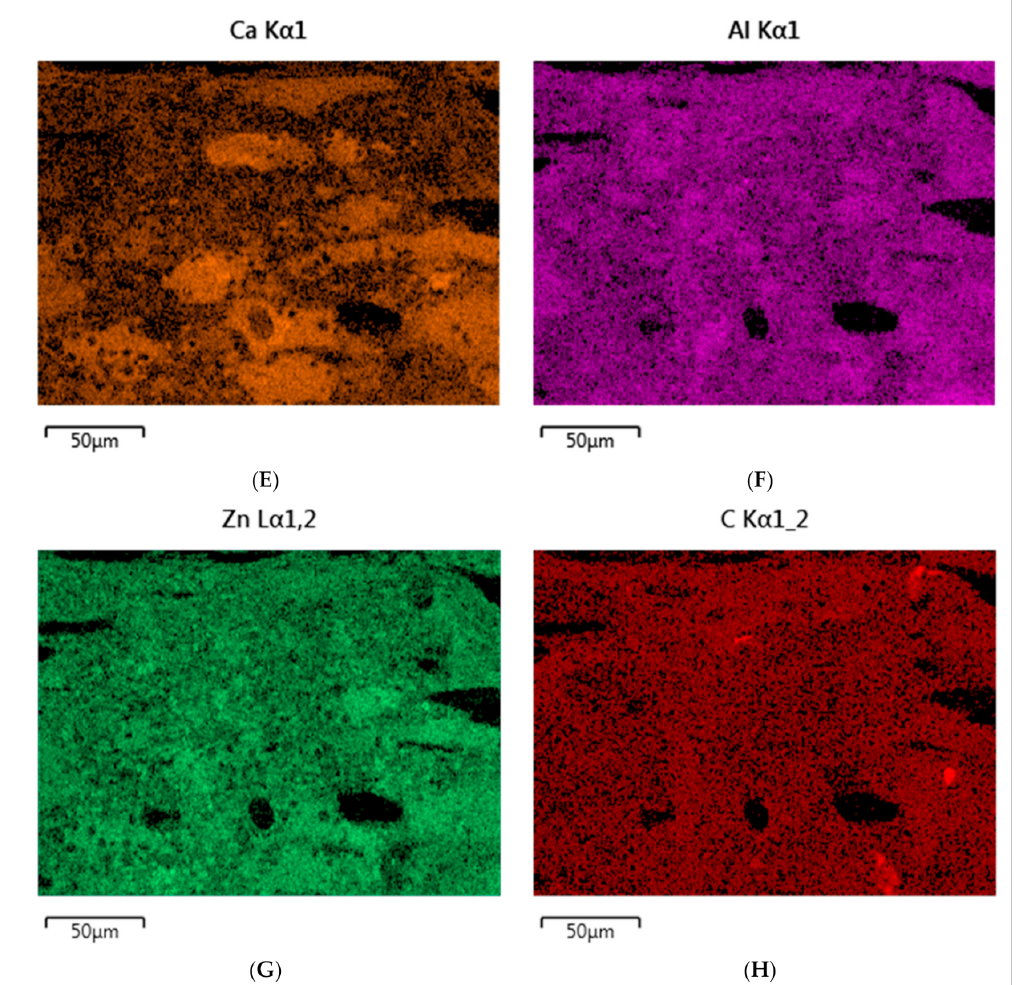
Figure 16. SEM images of SR-5 composite after its ceramization At a magnification of ( A ) × 200 and ( B ) × 500. EDS mapping of SR-5 ( C ) silicon distribution, ( D ) oxygen distribution, € calcium distribution, ( F ) aluminum distribution, ( G ) zinc distribution, and ( H ) calcium